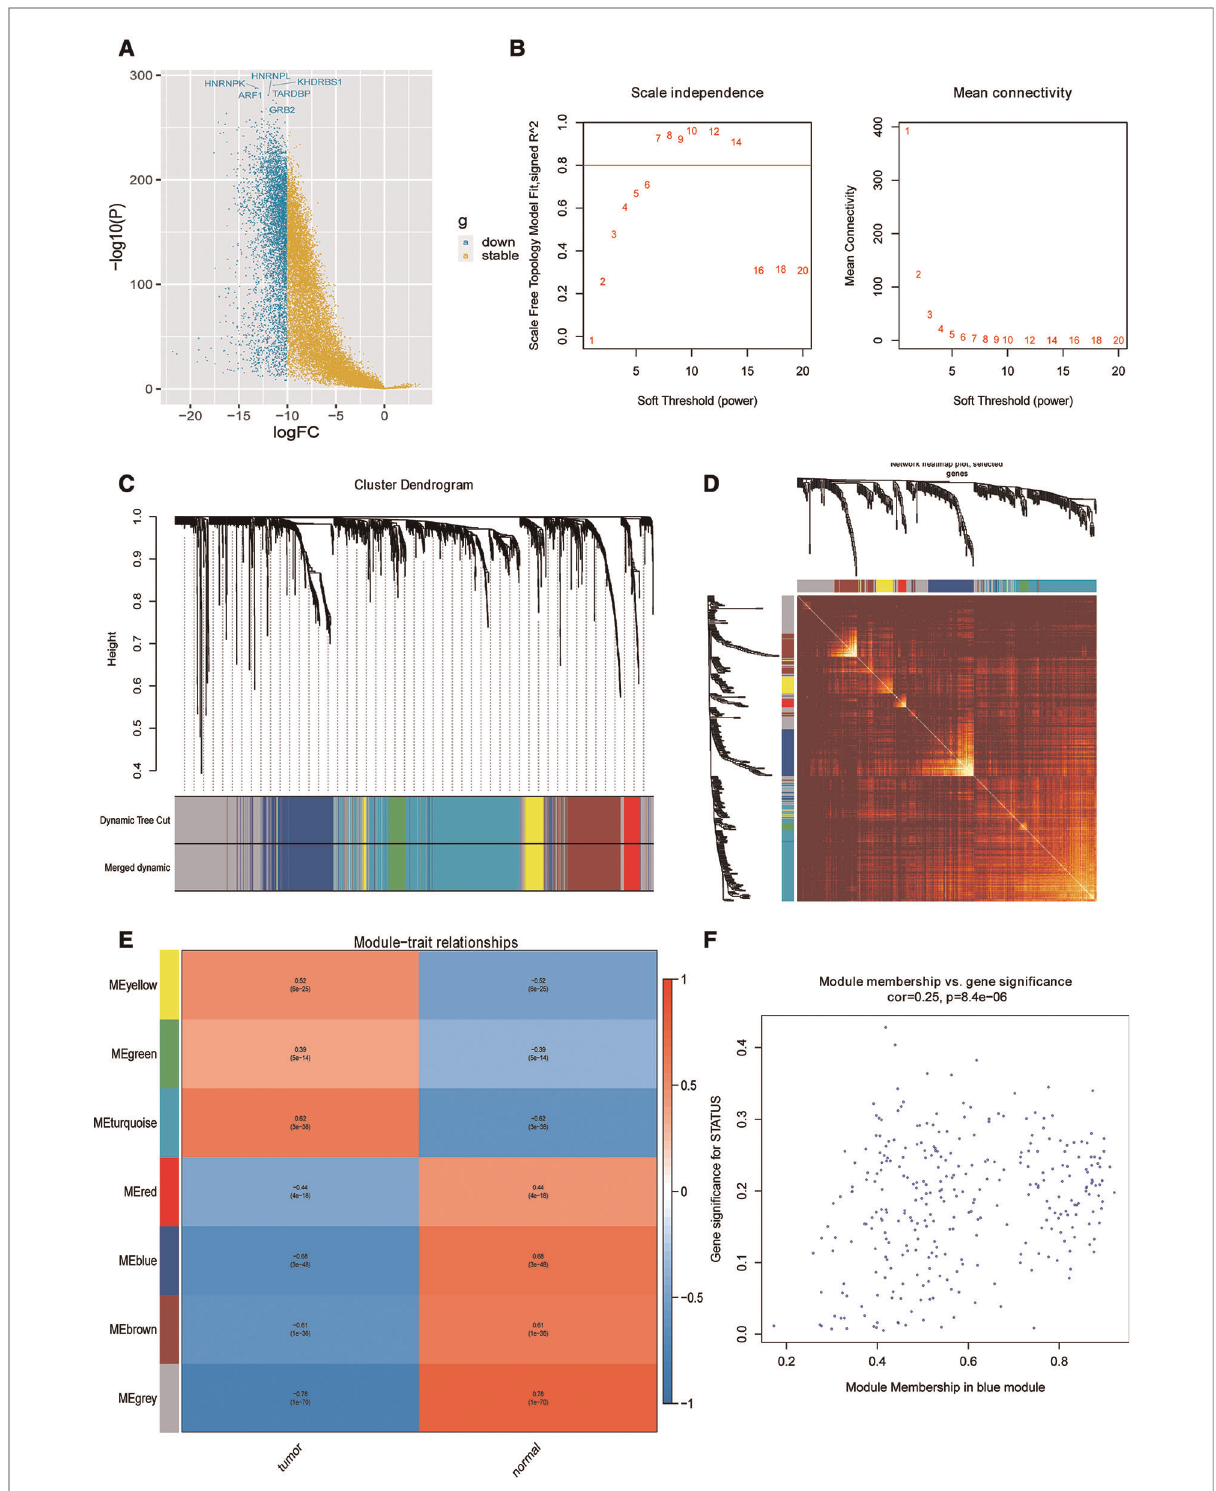
FIGURE 1 Identi fi cation of phenotypic-speci fi c differentially expressed genes (DEGs). ( A ) Differential gene volcano map between Oral squamous cell carcinoma (OSCC) samples and normal samples. ( B ) Soft threshold power analysis for generating the scale-free fi tting index of network topology. ( C ) Hierarchical cluster analysis to detect co-expression clusters with corresponding color assignments. ( D ) Heat map depicting the topological overlap matrix between DEGs based on co-representation module (TOM). ( E ) Heat maps of correlations between modular signature genes and OSCC phenotypes. ( F ) Scatter plot of the correlation between blue module and genes most correlated to